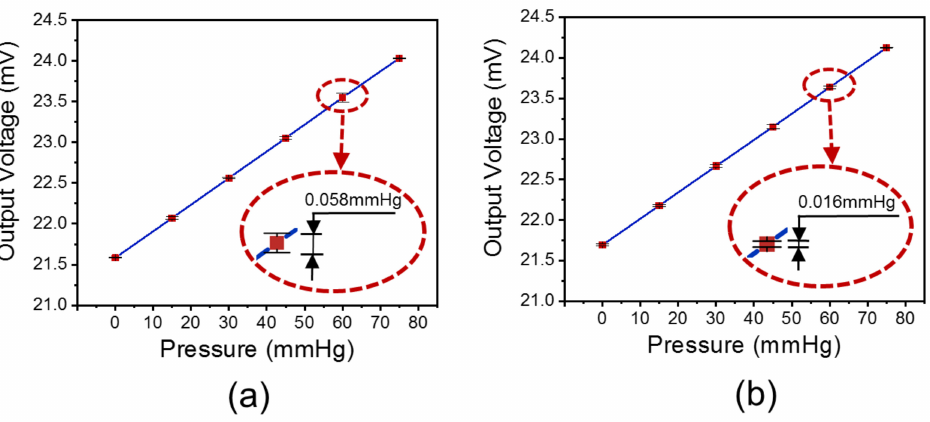
Figure4. ( a )Thevoltage-pressurecharacteristiccurveofthepressuresensorbeforetheaccuracy-improving, post-processing method. ( b ) The voltage-pressure characteristic curve of the pressure sensor after the accuracy-improving, post-processing method.